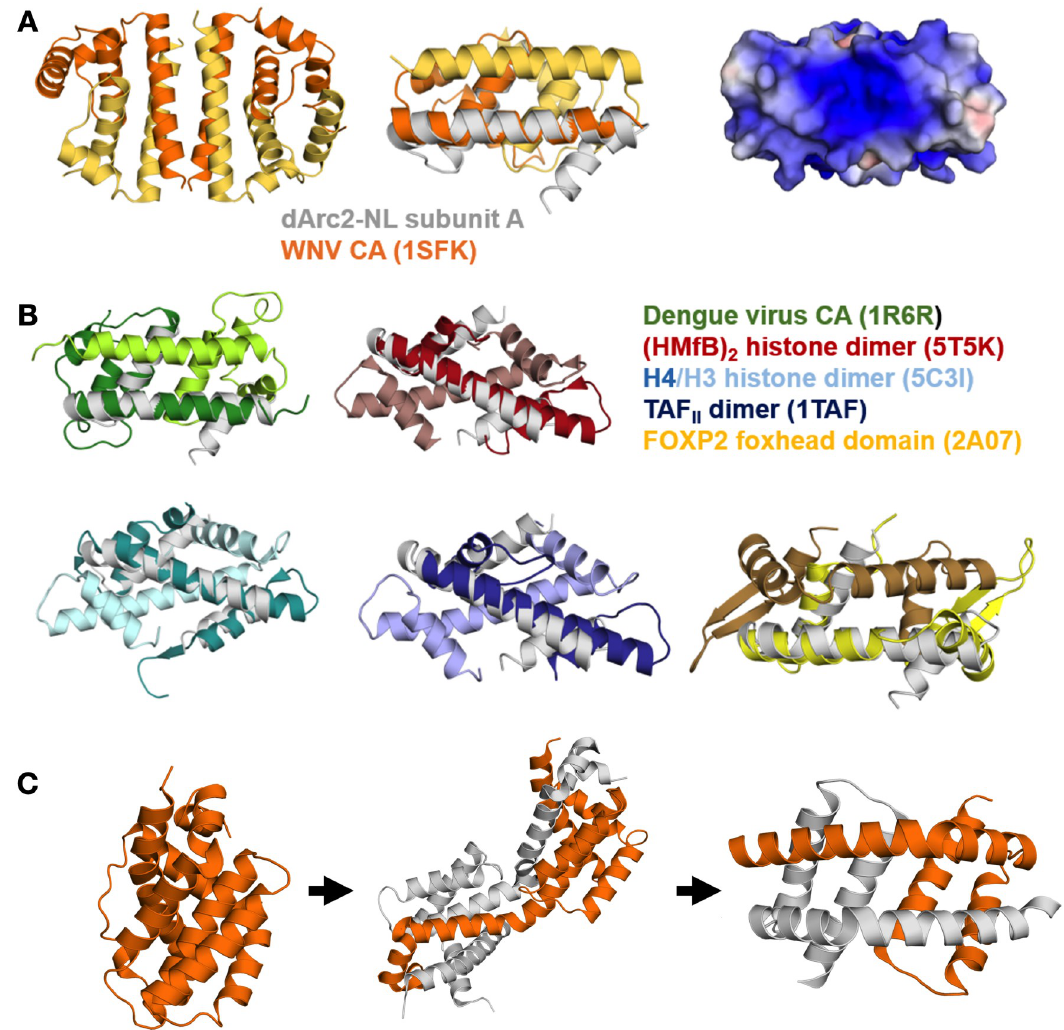
Fig 4. The dArc2-NL domain-swapped dimer resembles flaviviral coat proteins and DNA-binding proteins. (A) The tetrameric coat protein of the Kunjin subtype West-Nile virus (WNc), where the longest helix of each monomer (analogous to α 2 of dArc2-NL) contributes to a four-helix bundle interface (PDB: 1SFK [59]) (left). Middle: a single dimer of the tetramer (yellow/orange) overlaid with subunit A from dArc2-NL (grey). Right: the electrostatic surface potential of a WNc dimer, which resembles that of dArc2-NL. (B) Structural comparison between the dArc2-NL and similar domain-swapping proteins. Shown are the retroviral Dengue virus CA (green; PDB: 1R6R [57]) and the DNA binding dimers of (HMfb) 2 histone (red; PDB: 5T5K [61]), a dimer of histones H3 and H4 (cyan; PDB: 5C3I [62]), TAF II transcription factor (blue; PDB: 1TAF [63]) and the foxhead domain of the FoxP2 transcription factor (yellow; PDB: 2A07 [64]). Each chain in a dimer is coloured with a different shade, and a dArc2-NL monomer is superimposed and shown in grey. (C) Domain swapping and conformational selection in the apoptosis-induced BAK protein. Shown on the left is the inactive monomeric form of BAK (PDB: 2IMT [65]), which has an orthogonal bundle fold similar to Arc-NL. Binding of a BH3 domain causes partial unfolding and opening of the hinge region (middle, PDB: 4U2U [66]), which leads to the formation of a membrane-binding domain-swapped dimer (right, PDB: 4U2V [66]). Panel C is based on [67]. The two chains in the BAK dimer are coloured grey and